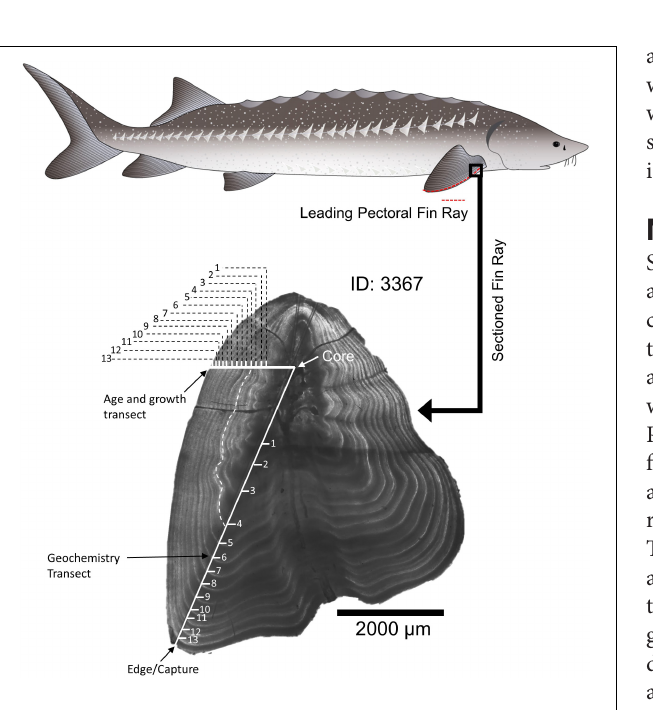
FIGURE 2 | Example fin ray with microstructure and microchemistry analysis trajectories indicated. The white dashed line follows an annulus from the transect used for geochemistry to the transect used for aging. Drawing of White Sturgeon by Adi